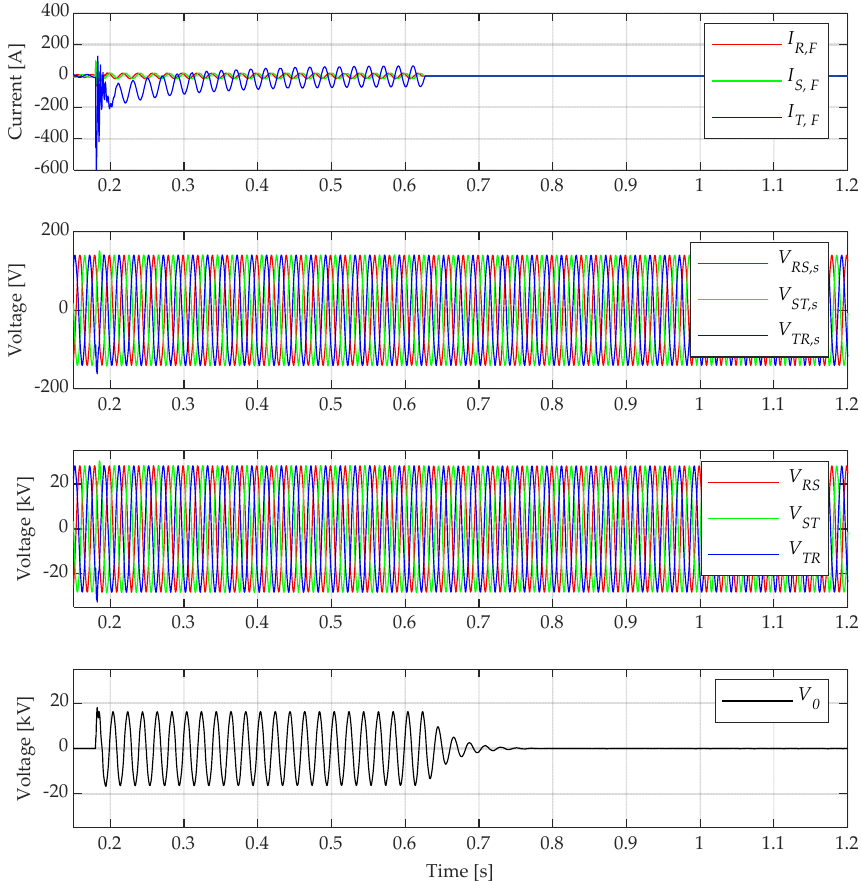
Figure 5. Case 1 (CN system) simulation results, from top to bottom: faulted line currents, line-to-line voltages at the secondary of the VT, line-to-line voltages at the MV busbar, homopolar voltage .